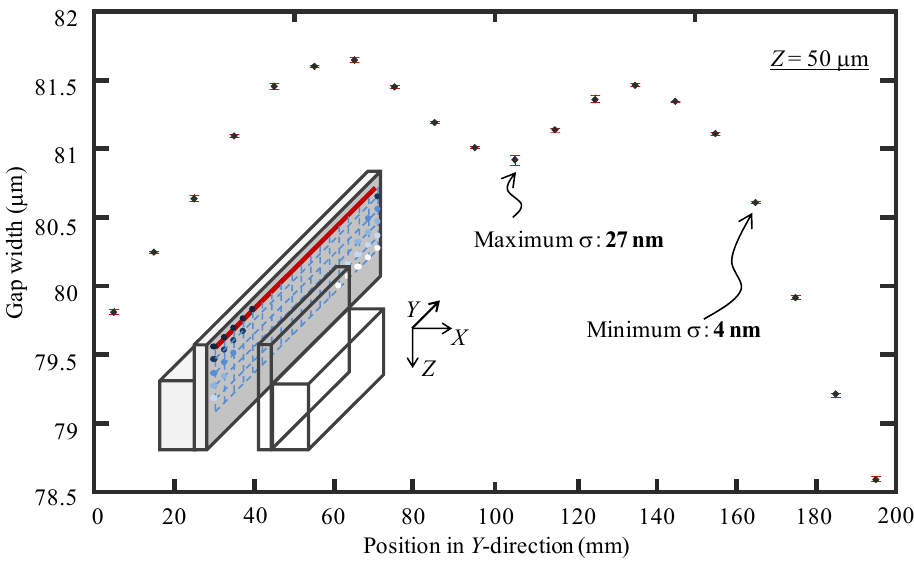
Figure 16. Measurement results of gap uniformity of slot die along the Y ‐ direction.